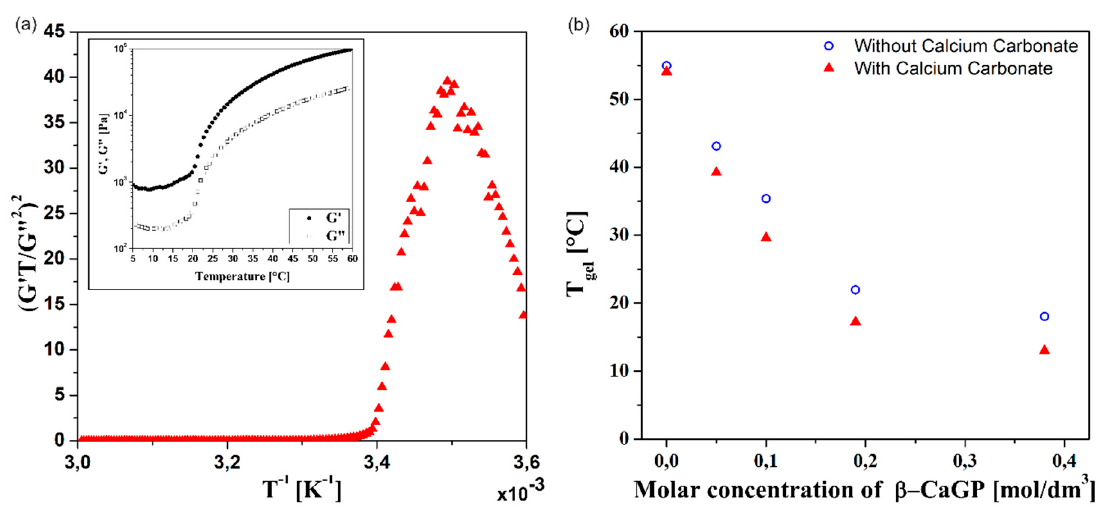
Figure 7. ( a ) Application of the Fredrickson-Larson method to determine the phase transition point for the medium with the predominance of elastic properties—sample 5CC. ( b ) Effect of the addition of calcium carbonate on the gelation temperature.